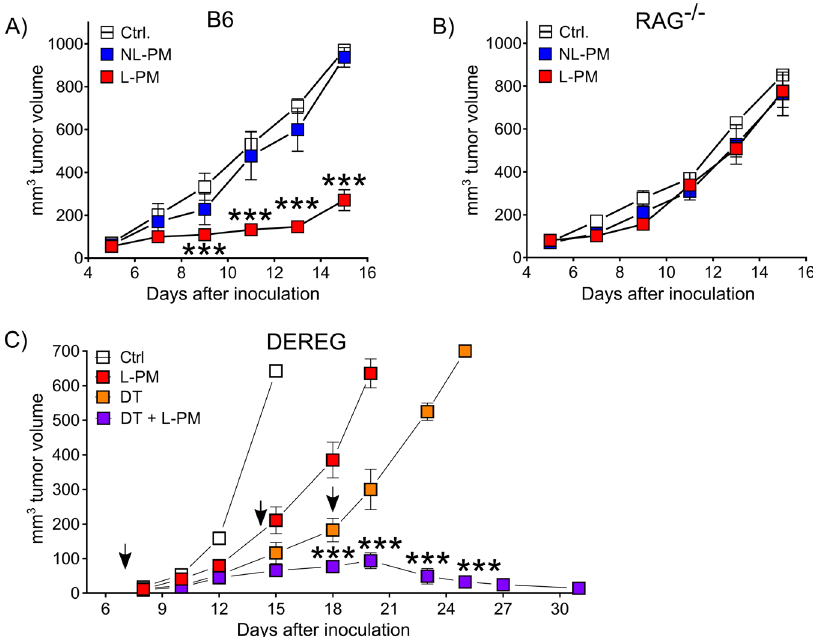
Fig. 3 MDL-loaded micelles repress melanoma growth. Inhibition of B16 melanoma growth by peritumorally injected MDL-loaded micelles in A C57BL/6 mice, B B6.RAG − / − and C DEREG mice. Mice were inoculated s.c. with B16-OVA tumor cells and received peritumoral micelle injections every other day starting from day 4 after inoculation. A Representative results of three independent experiments shown as mean ± SEM, Ctrl (white) n = 5, L-PM (red) n = 6, NL-PM (blue) n = 5, *** P = 0.000988 (day 9), *** P = 0.000989 (day 11), *** P = 0.00099 (day 13), *** P = 0.00098 (day 15) (parametric unpaired two-sided t -test with Holm – Š ídák-corrected P values, alpha = 0.05, 0.95 con fi dence interval). B Representative results of three independent experiments shown as mean ± SEM, n = 5 per group, P -values did not reach statistical signi fi cance (parametric unpaired two-sided t -test with Holm – Š ídák-corrected P values. C Some mice received additional diphtheria toxin (DT) injections at days 7, 14, and 18 (arrows). Representative results of two independent experiments shown as mean ± SEM, Ctrl (white) n = 5, L-PM (red) n = 4, DT (orange) n = 4, DT + L-PM (violet) n = 5, Ctrl vs. L-PM: *** P = 0.00098 (day 15); Ctrl vs. DT: ** P = 0.007 (day 12), *** P = 0.00098 (day 15); DT vs. DT + L-PM: *** 'P = 0.000998 (day 18), *** P = 0.000997 (day 20), *** P =